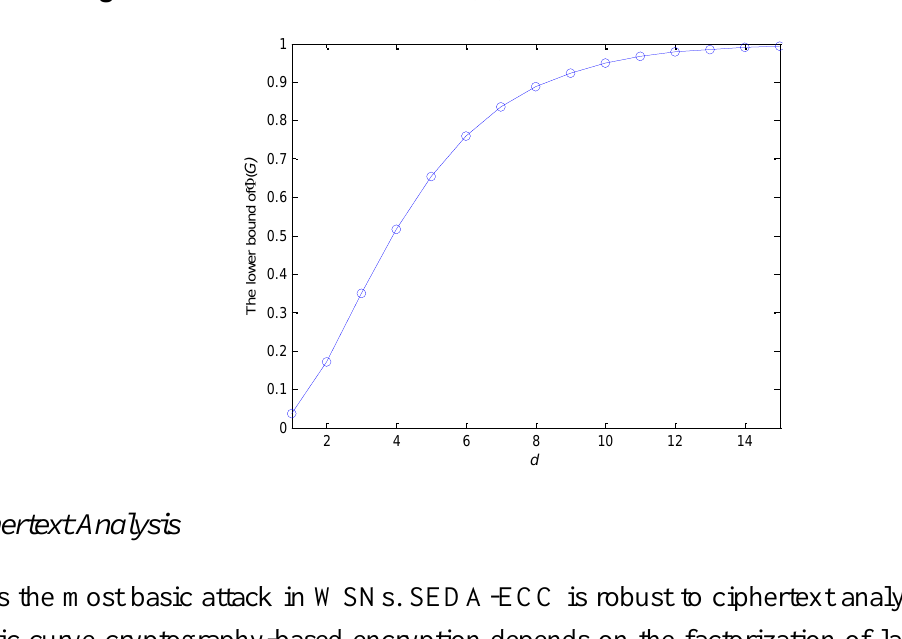
Figure 3. The lower bound of Φ ( G ) which varies with the variation of d